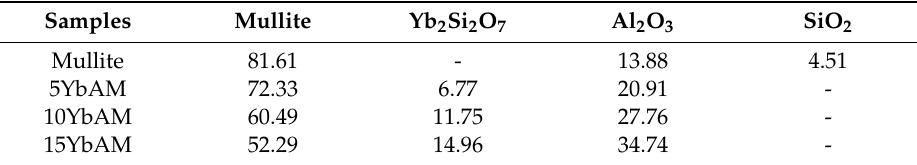
Table 1. Phase compositions and contents of the samples (wt %).